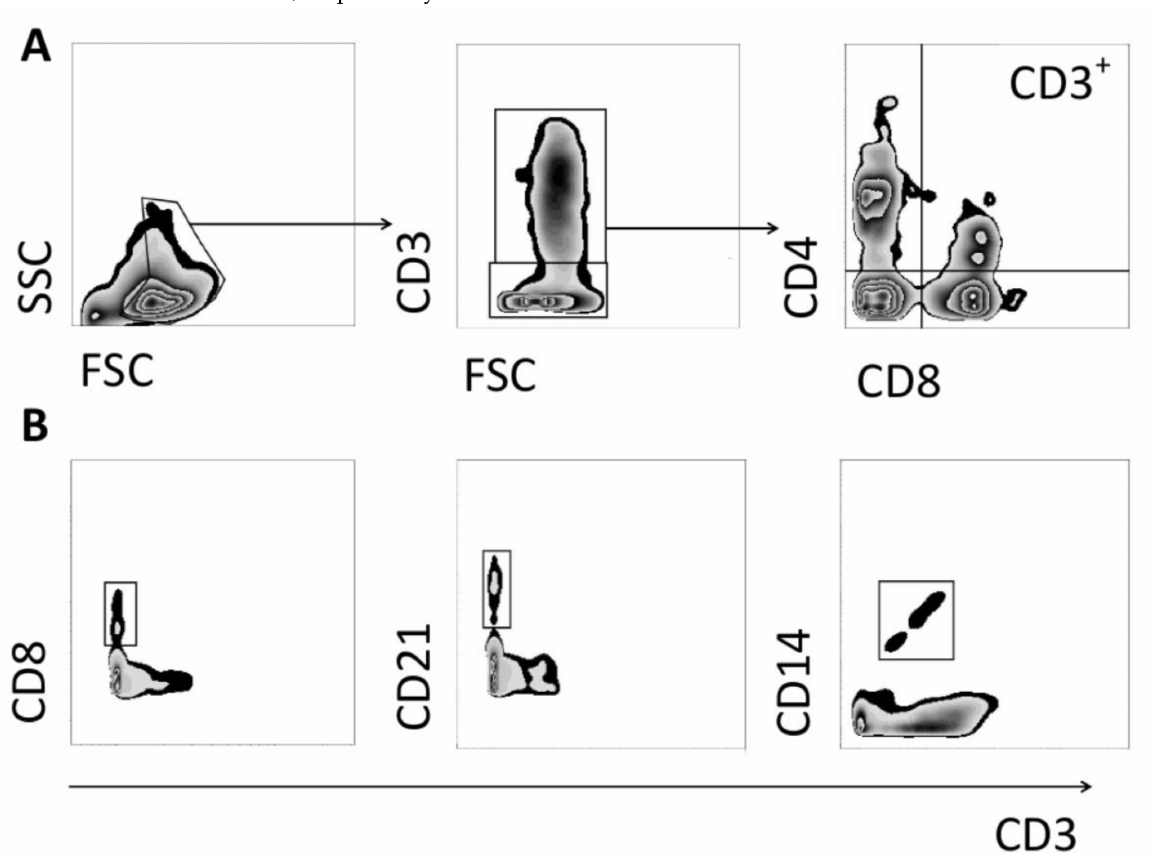
Figure 1. Gating strategy applied to flow cytometry data. ( A ) Viable cells were selected based on FSC and SSC, followed by establishing a gate of CD3 + and CD3 − gates. Further gates based on CD4 and CD8 markers were established within CD3 + gate. ( B ) Gates based on CD3 and CD8, CD21, CD14 markers were established within viable cell